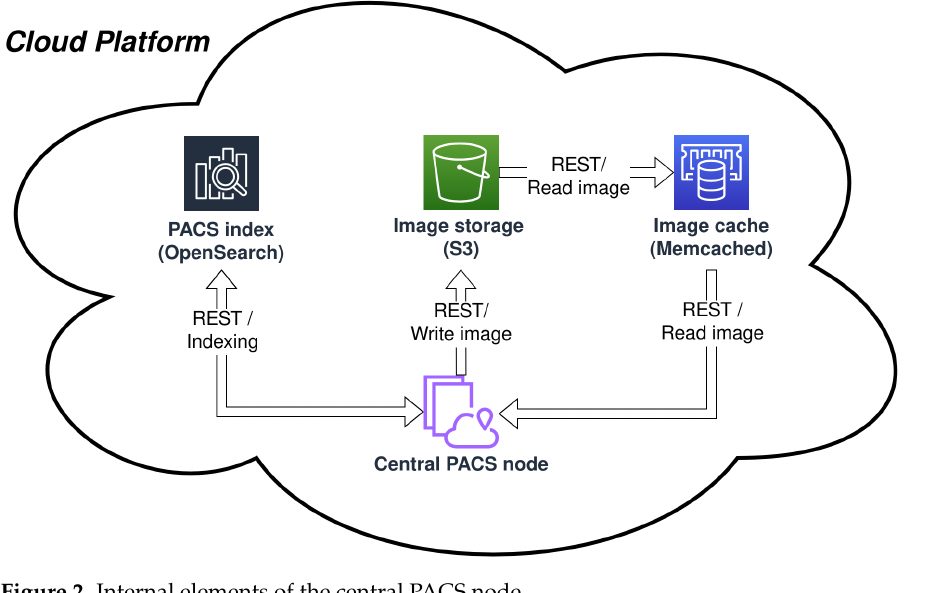
Figure 2. Internal elements of the central PACS node.